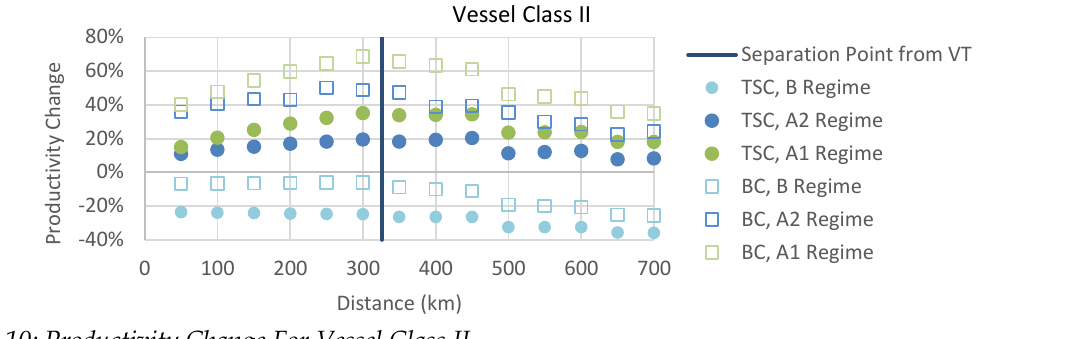
Figure 9: Productivity Change Plots for Vessels V and IV